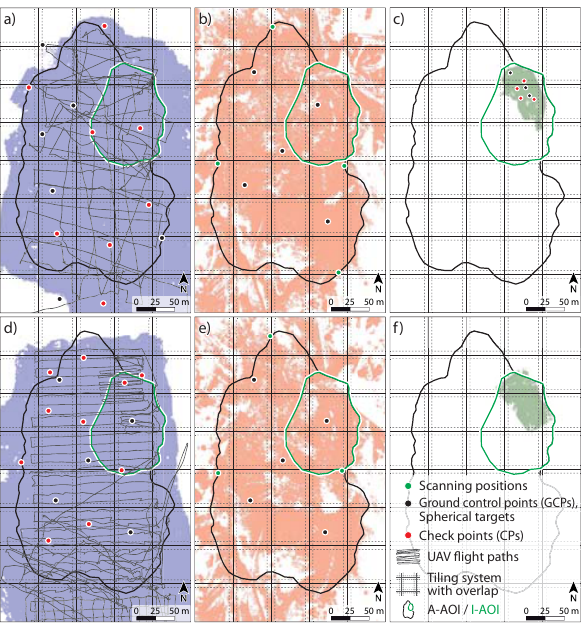
Figure 5. Setup of the two field campaigns, showing the coverage of the UAV flights in 2016 (a) and 2017 (d), TLS acquisitions in 2016 (b) and 2017 (e) and TerrPh acquisitions in 2016 (c) and 2017 (f). Superimposed, the tiling system is